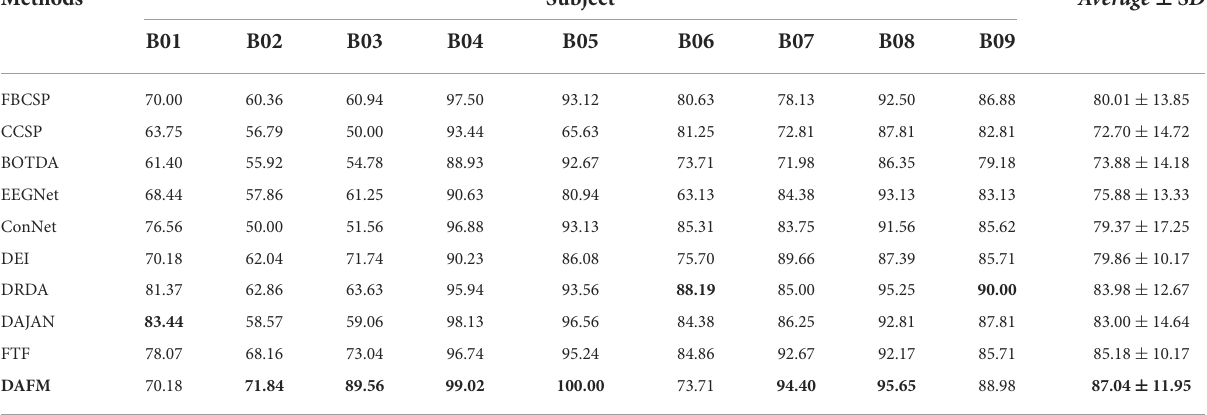
TABLE 4 Classification accuracies ( % ) obtained with the dataset BCI competition